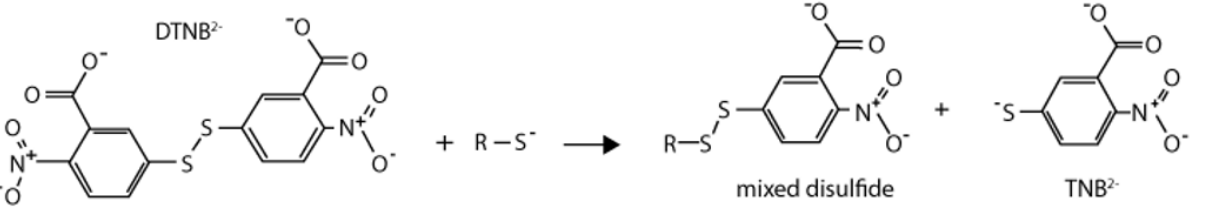
Figure 1. Ellman’s reaction.